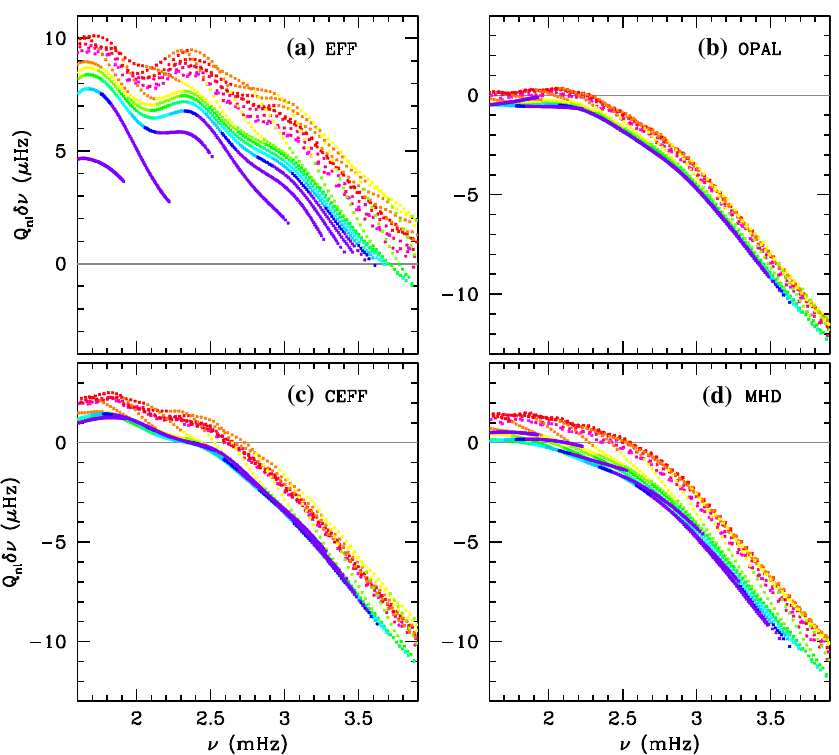
Fig. 6 The scaled frequency differences between the Sun and four models constructed with different equations of state but otherwise identical inputs. The OPAL model is Model S of Christensen-Dalsgaard et al. (1996). Colours are the same as in Fig. 4. (Models courtesy of J.